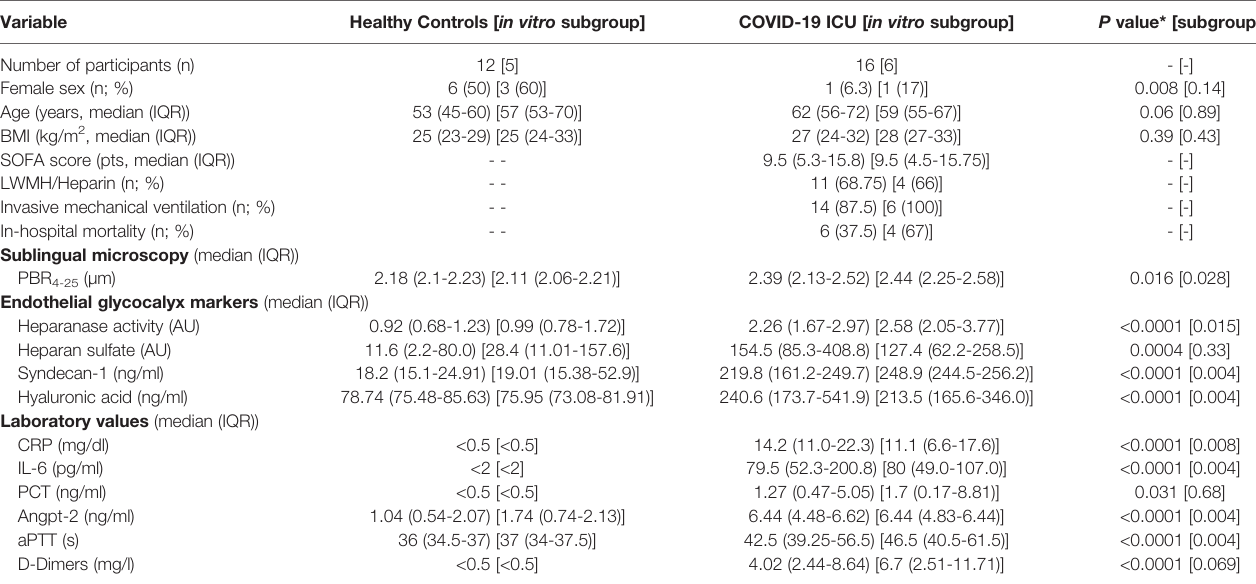
TABLE 1 | Baseline